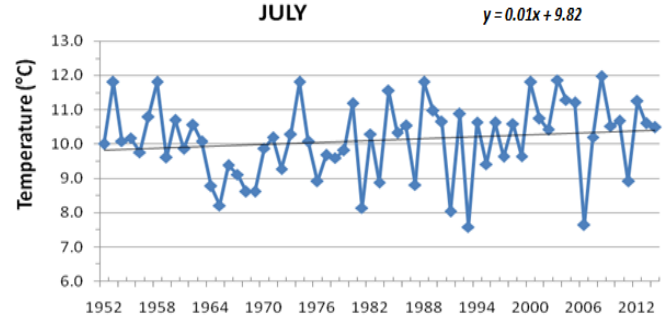
Figure 6. The time series of the July minimum temperature.